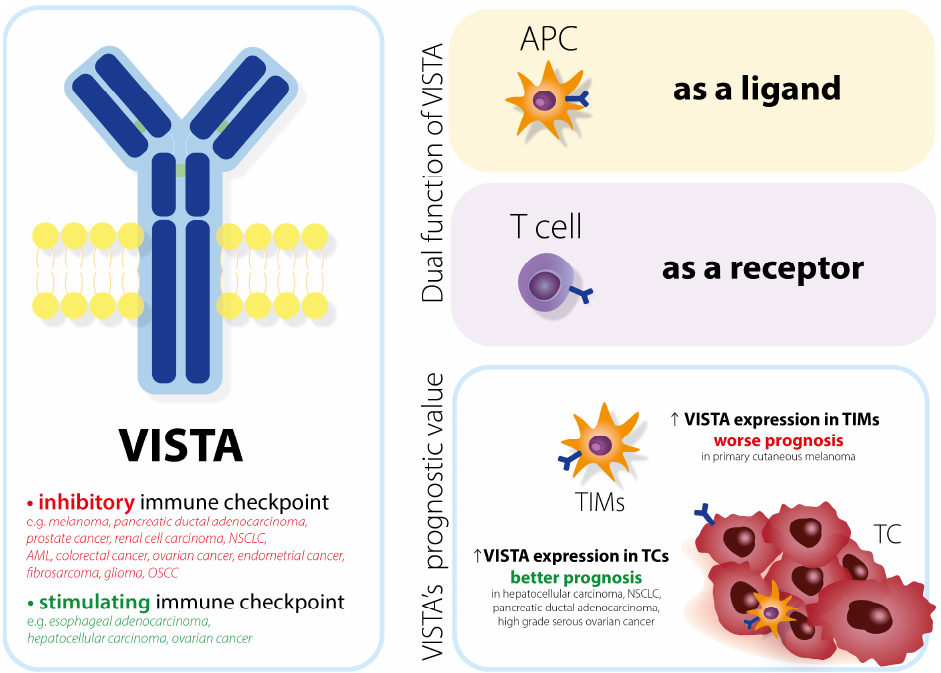
Figure 1. Main functions of VISTA. Depending on the cell type, VISTA can act as a ligand and as a receptor. VISTA as an immune checkpoint differs among cancers. Whether it has an inhibitory or stimulating function determines the progression of carcinogenesis. In certain types of cancer, VISTA expression makes the prognosis better. VISTA = V-domain Ig suppressor of T cell activation; APC = antigen presenting cell.